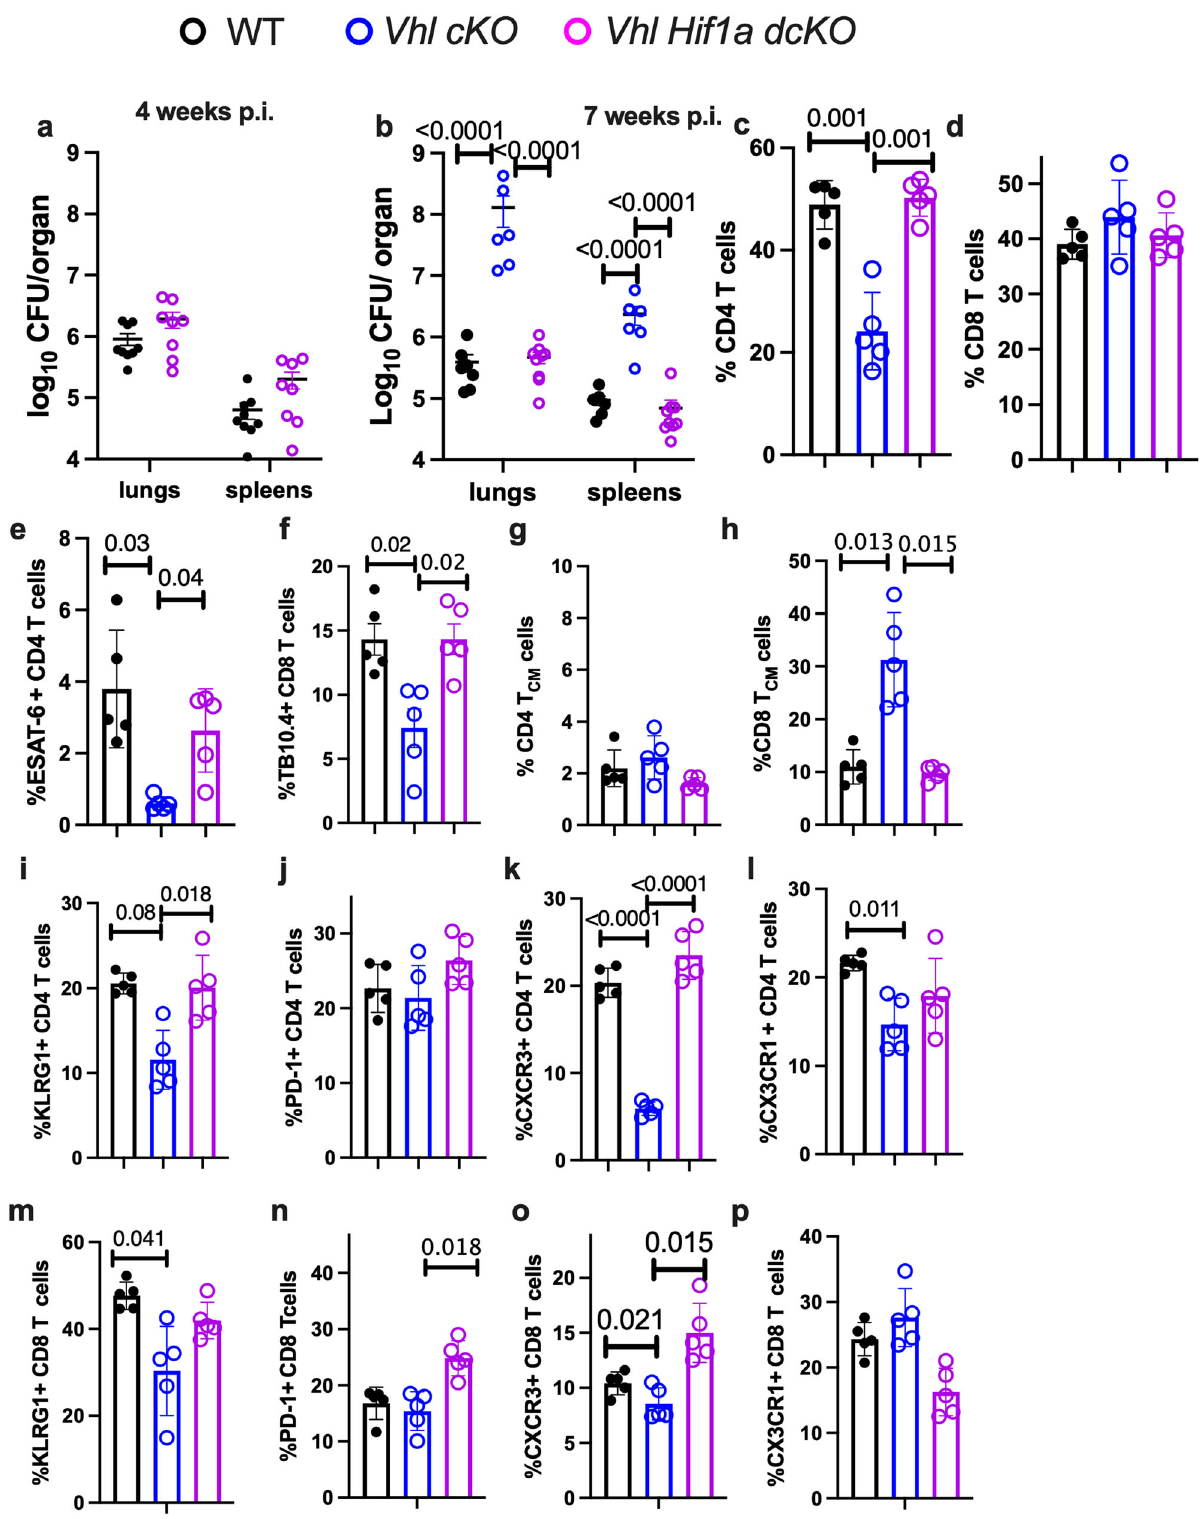
Fig. 7 | HIF-1mediates the susceptibility to M. tuberculosis -infectionof VhlcKO mice. a , b Vhl cKO, Vhl Hif1a dcKO and WT mice were sacri fi ced at 4 ( a ) and 7 ( b ) weeksafteraerosolinfectionwith M.tuberculosis .Thelog 10 CFUinlungsandspleens aredepicted;( a )WT n =9, VhlHif1adcKOn =8,( b )WT n =6, VhlcKOn =6, VhlHif1a dcKOn =9. c , d ThefrequencyofCD4( c )andCD8( d )Tcellsinthelungof VhlHif1a dcKO , VhlcKO andWTmice7weeksafter M.tuberculosis infectionisshown. e , f The percentage of tetramer ESAT-6-binding CD4 T cells ( e ) and TB10.4-binding CD8 Tcells( f )inthelungof VhlHif1adcKO , VhlcKO andWTmice7weeksafterinfection